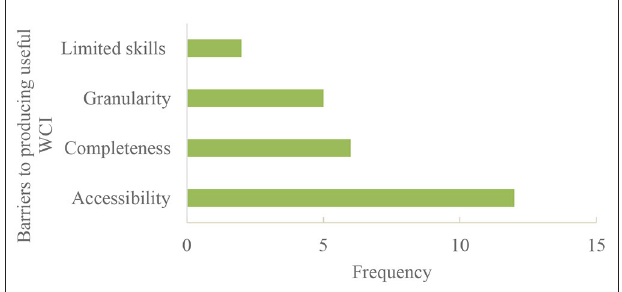
FIGURE 3 | Barriers that hinder production of useful WCI.